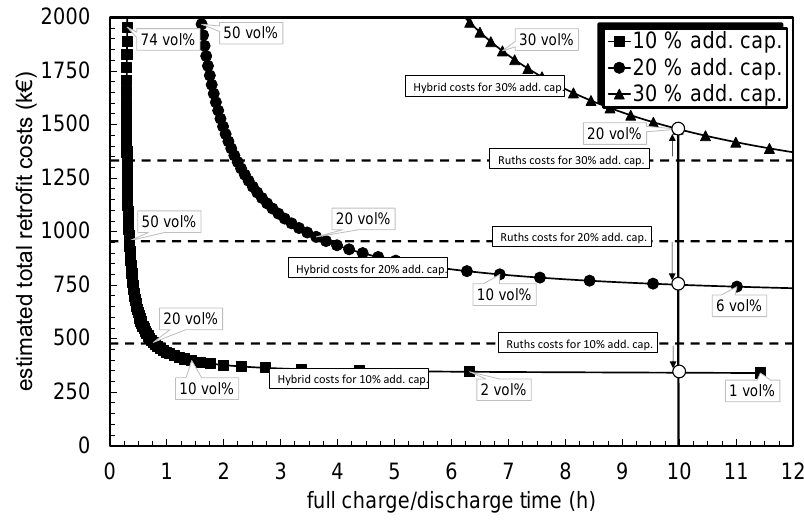
Figure 8. Charge/discharge time vs costs for additional storage capacity with hybrid and Ruths variant. Al content in PCM is given in vol%.